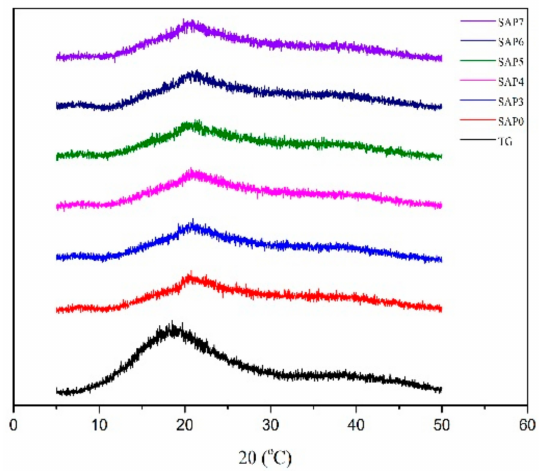
Figure 4. XRD pattern of TG and the